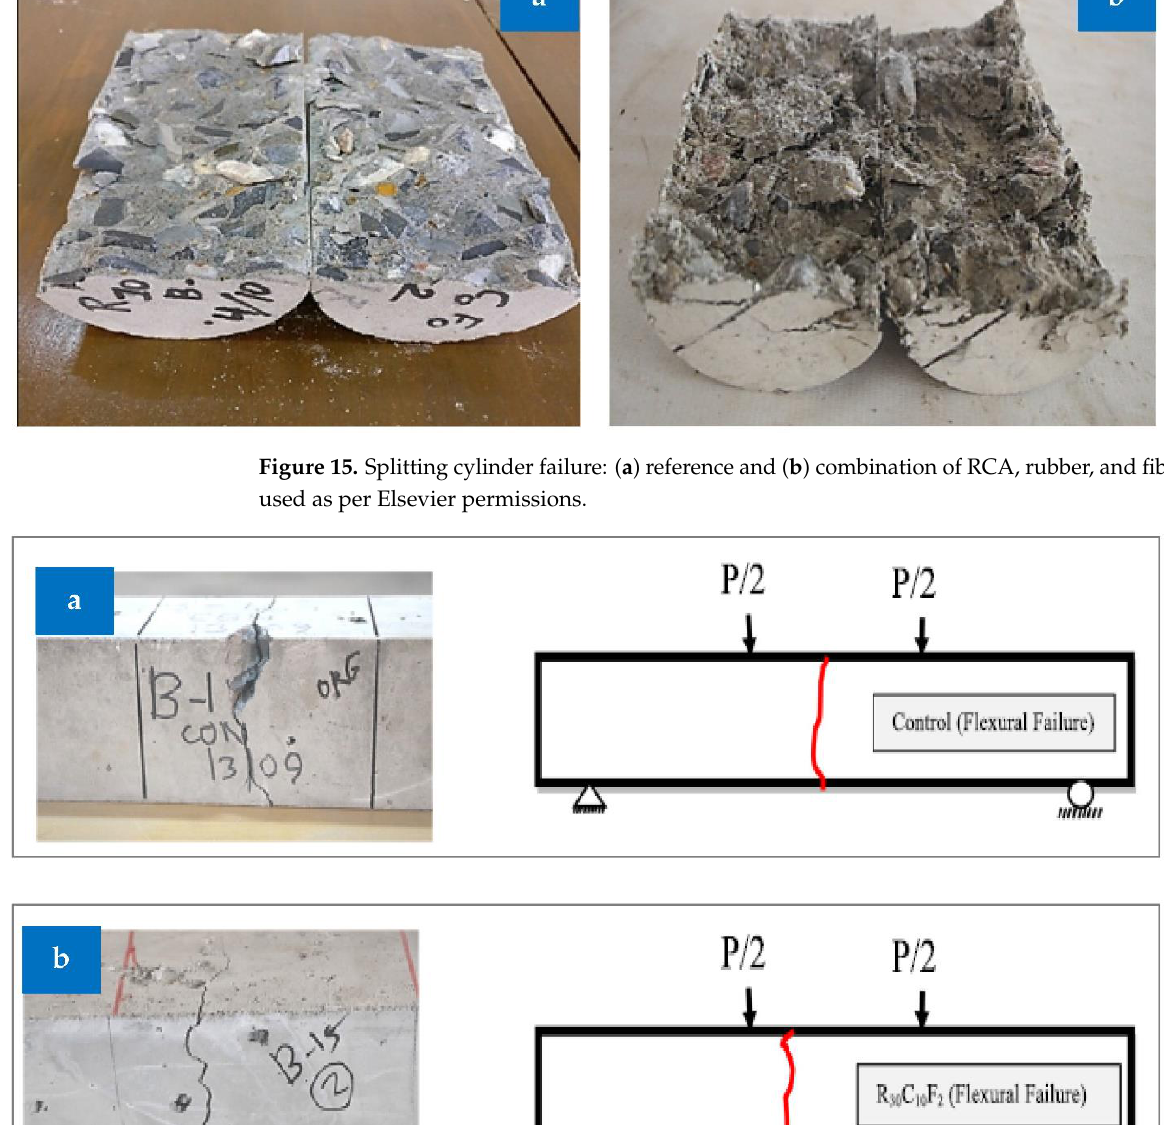
Figure 14. Cylinder failure under compression: ( a ) reference and ( b ) combination of RCA, rubber, and fibers [44]: used as per Elsevier permissions.